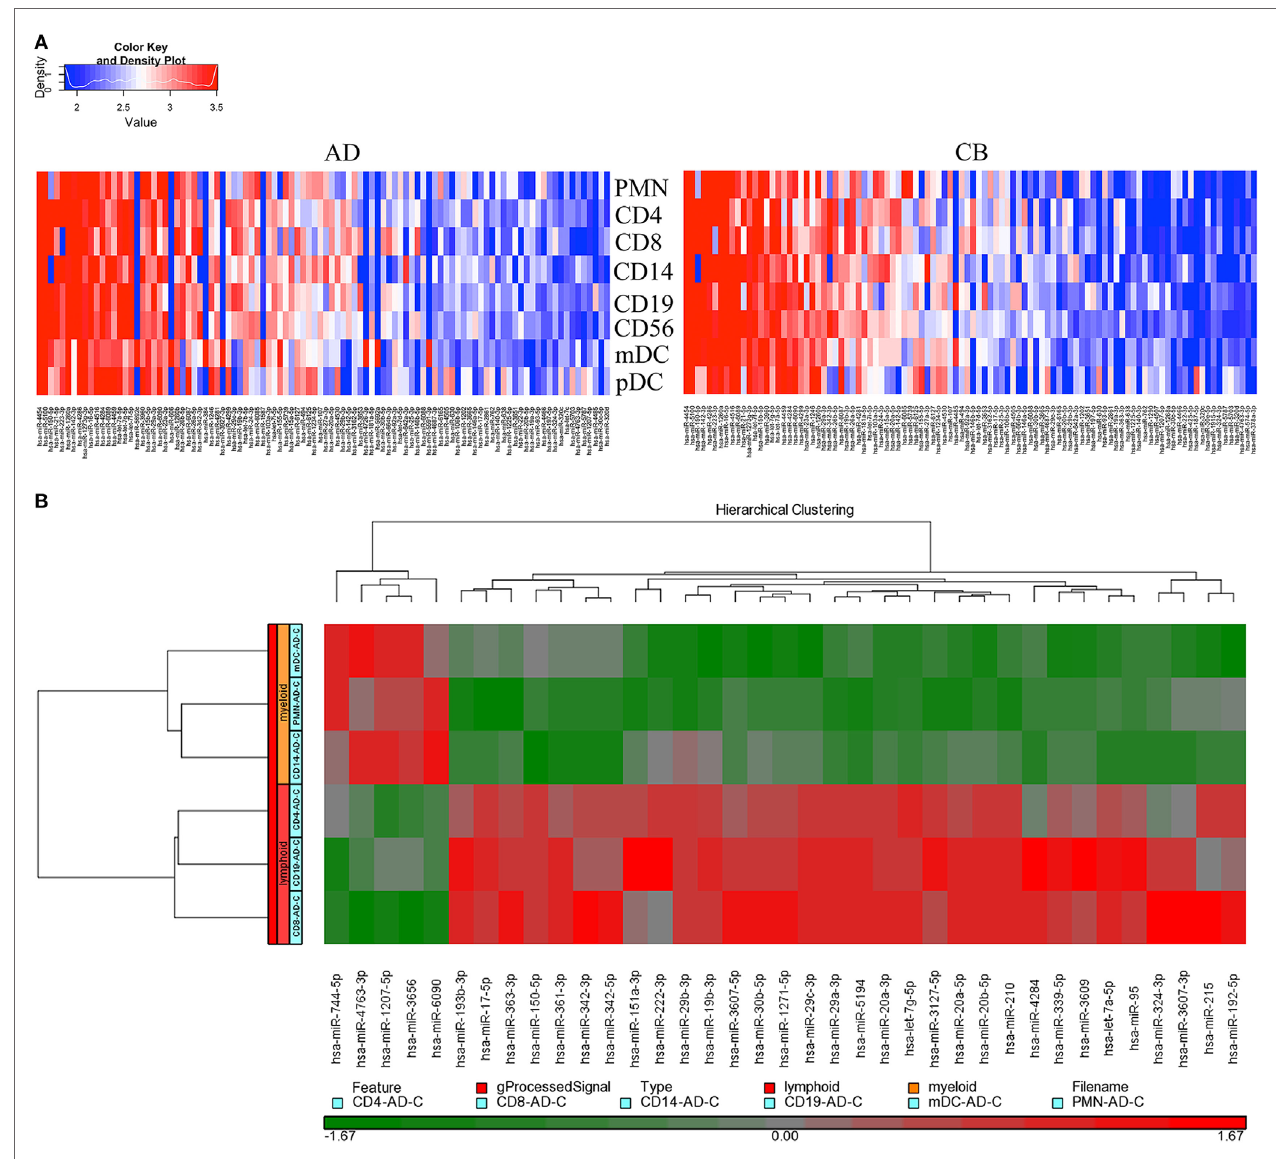
FigUre 1 | Distinct microrna (mirna) expression between adult and neonatal leukocytes . (a) Neonate leukocyte subsets show distinct miRNA expression compared to adult leukocytes. Heat map showing distinct expression of miRNAs from different leukocyte subsets of adult peripheral blood (left) and cord blood (right). Each heat map lane represents the top 100 expressed miRNAs in each leukocyte subset. Higher intensity is shown in red and lower intensity in blue. (B) Myeloid and lymphoid leukocytes have unique miRNA profiles. Heat map showing distinct expression of miRNAs from myeloid (polymorphonuclear cells, CD14 + monocytes, and myeloid dendritic cells) and lymphoid (CD4 + T cells, CD8 + T cells, and CD19 + B-cells) leukocyte subsets. Thirty-seven miRNAs with the highest transcript levels across all tested cell lineages were shown. Higher intensity is shown in red and lower intensity in